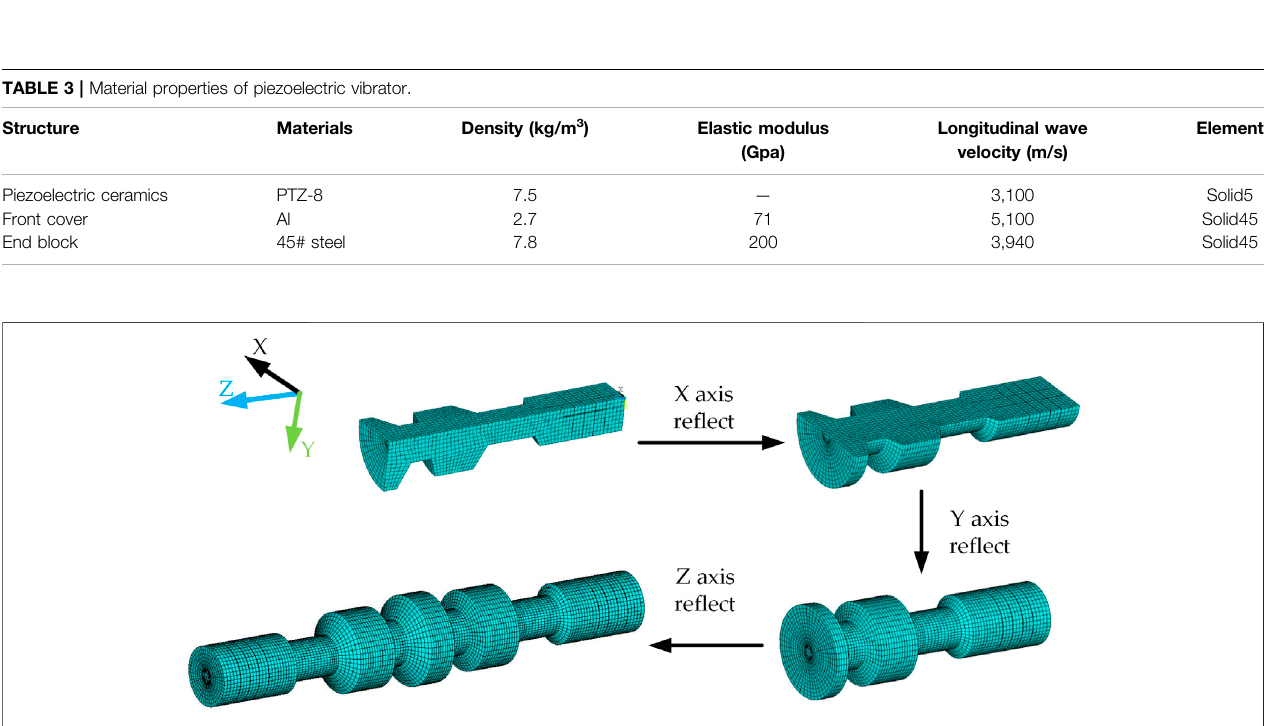
FIGURE 10 | Establishment of fi nite element